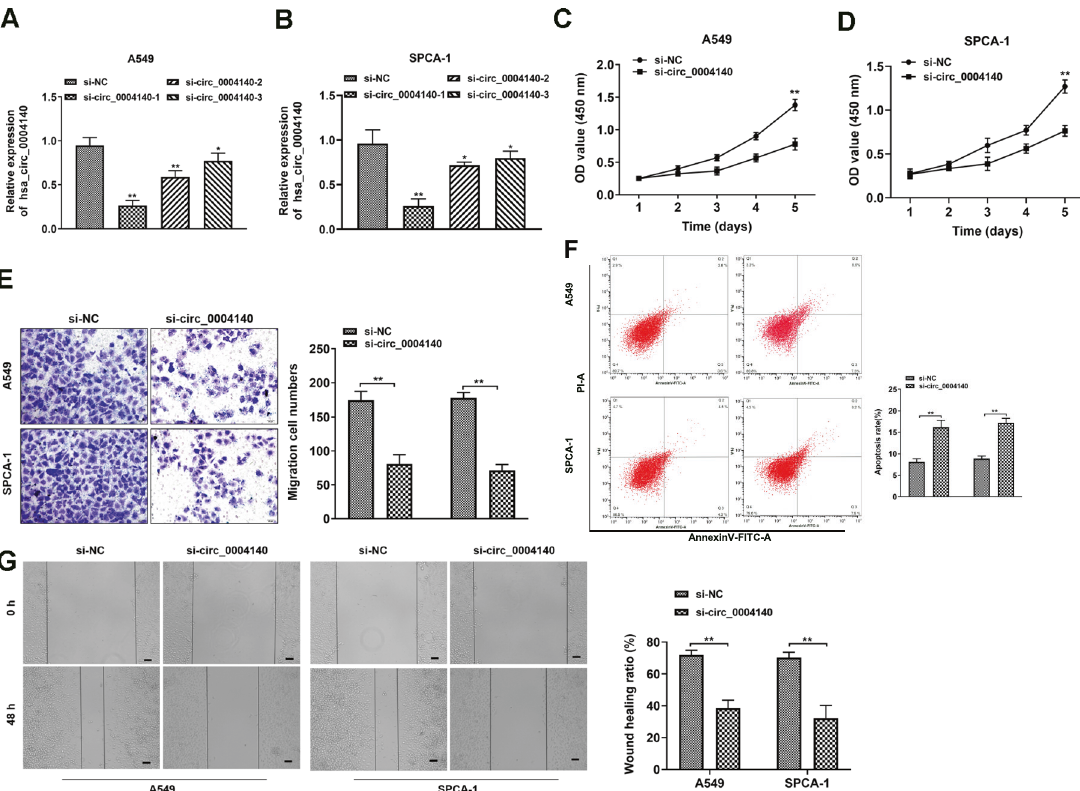
Fig. 2 circ_0004140 promotes the proliferation, migration and apoptosis in LUAD cells. A , B Three different siRNAs were used to determine the most knockdown ef fi ciency in A549 cells ( A ) and SPCA-1 cells ( B ) measured by RT-PCR analysis ( n = 3). C , D Effect of circ_0004140 knockdown on cell viability in A549 cells ( C ) and SPCA-1 cells ( D ) determined by CCK-8 assay ( n = 3). E The effect of circ_0004140 on cell invasion was evaluated by transwell assay( n = 3). Scale bar = 20 μ m. F The apoptosis of LUAD cells was measured by staining with Annexin V/ PI, followed by FACS analysis ( n = 3). The abscissa indicated the number of cells positive for Annexin V, and the ordinate indicated the number of cells positive for PI. G The migrated ability of A549 and SPCA-1 cells was assessed through wound healing assay ( n = 3). Scale bar = 20 μ m. * p < 0.05, ** p < 0.01, ns non-signi fi cant. All the data are representative of at least three independent experiments and presented as the means ±